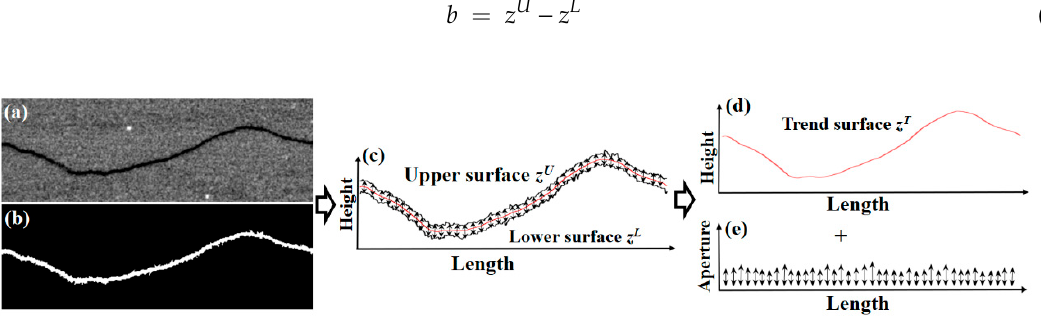
Figure 2. 2D view of a 3D fracture and its key components. A 2D CT slice image ( a ), its segmented fracture ( b ), its three identified components ( c ): upper, lower, and trend-surfaces (or curves in red), where the trend-surface describes fracture undulation ( d ) and the upper and lower surfaces together are used to determine fracture apertures ( e ).